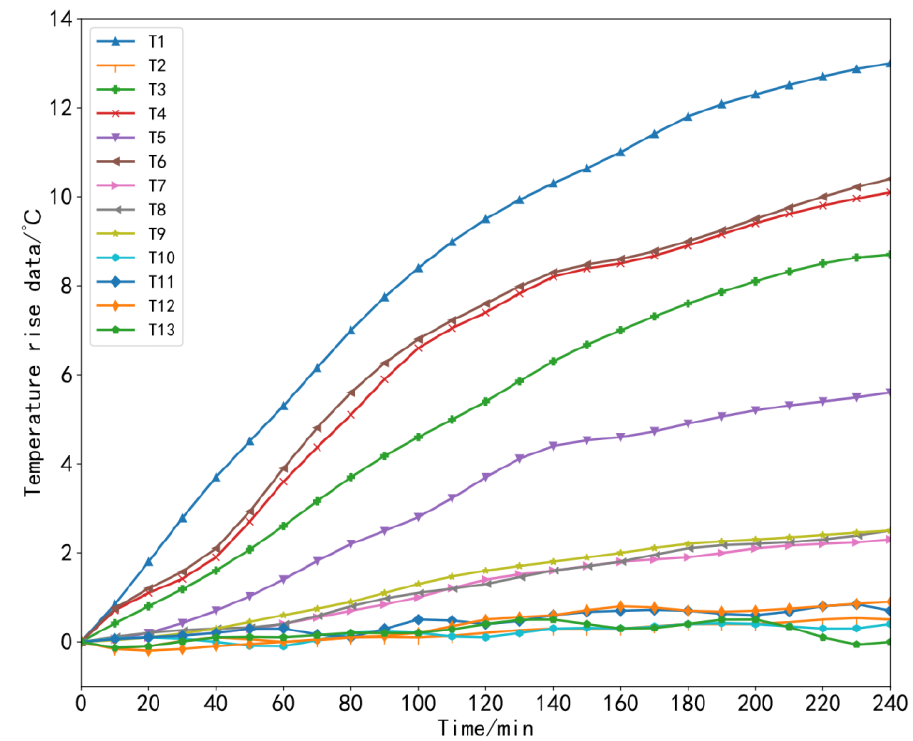
Figure 10. Temperature rise data at a speed of 5000 mm/min.